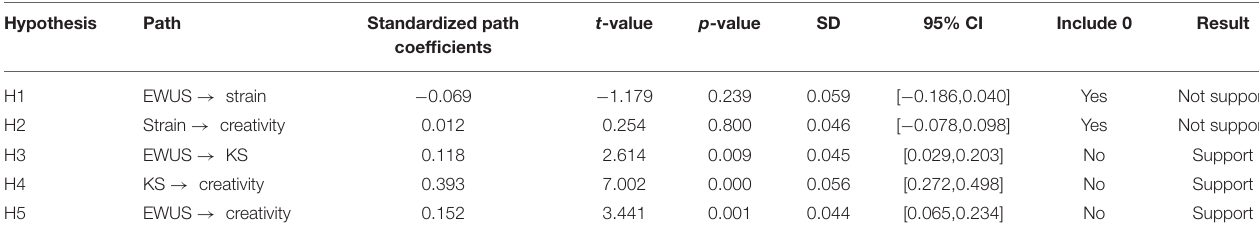
TABLE 6 | Standardized path coefficients, standard deviation, and 95%